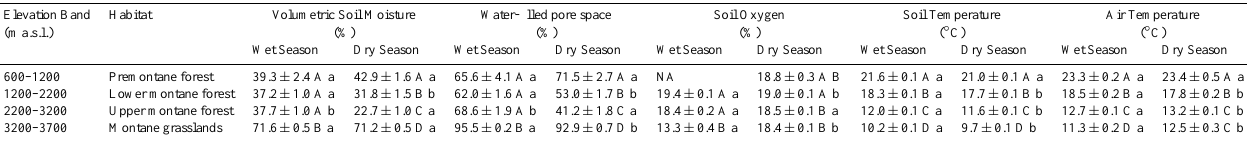
Table 3. Abiotic environmental variables for each habitat for the wet and dry season. Upper case letters indicate differences among habitats and lower case letters indicate difference among seasons within habitats (Fisher’s LSD, P < 0.05). Values reported here are means and standard errors.